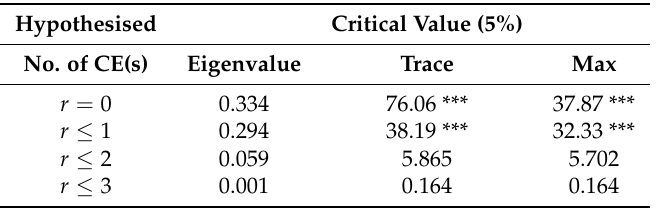
Table 3. Johansen and Juselius test. Trace and Max eigenvalue indicate two cointegration equation at 1%; *** indicates the rejection of null hypothesis at 1%.